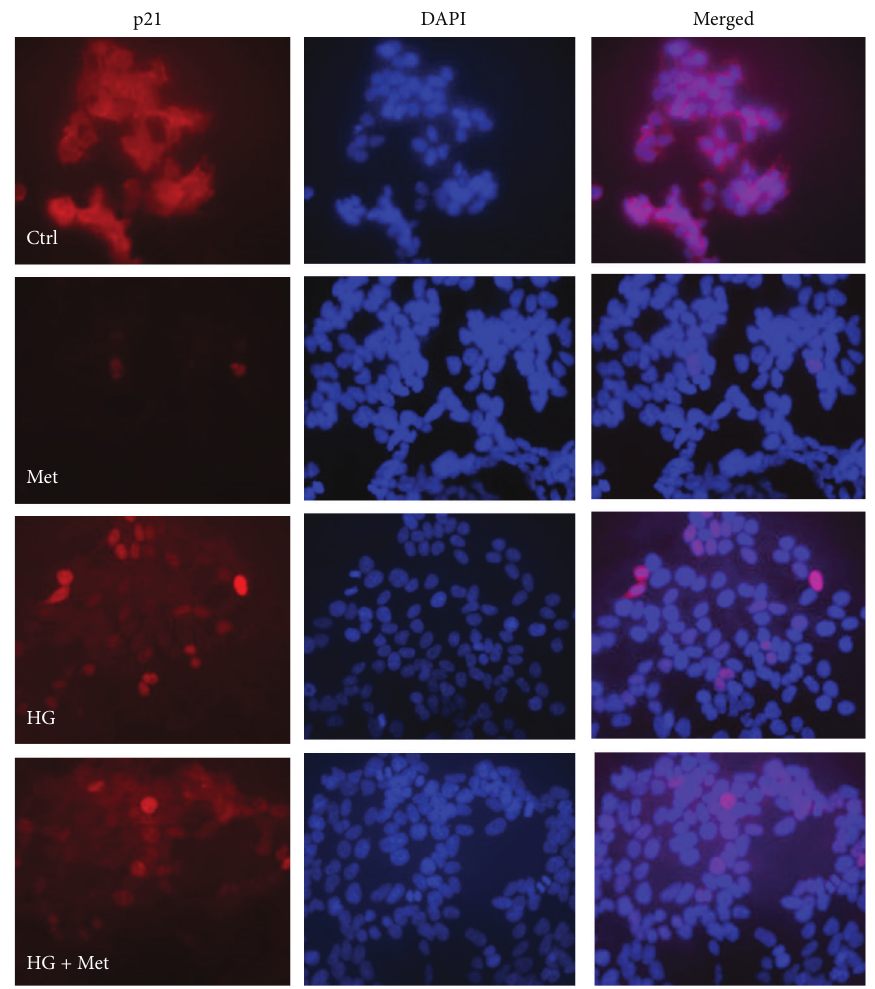
Figure 7: Detection of metformin-induced downregulation of p21 by immunocytochemistry. HEK293 cells were grown on glass slides until 60% confluence. The cells were cultured with 5.5 mM or 25mM (HG) D-glucose for three days. For the last 24 h, 8mM metformin (Met) was added to the indicated conditions. Original magnification × 400. Representative image of two independent